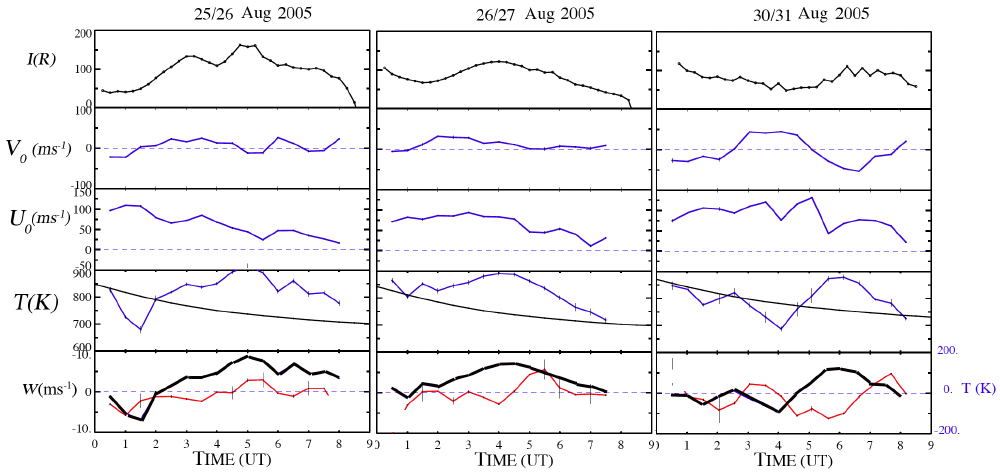
Fig. 6. Averaged intensities and Fourier decomposition analysis results for three nights in late August, 2005. Temporal variations of the averaged 630-nm intensity (all directions) and the computed mean speeds for the horizontal meridional (V0) and zonal (U0) wind components are plotted in the top three rows, respectively. The time sequence of cycle-averaged temperatures (blue data points and line) and the predicted values computed with the NRL-MSIS00 model (black line) are plotted in the fourth row. The red and black lines in the bottom row show the temporal variations of the vertical wind w and the temperature difference (FPI data minus the computed MSIS values), respectively. Local midnight is 05:00UT. The vertical black line for each data point indicates the range of ± 1 σ standard